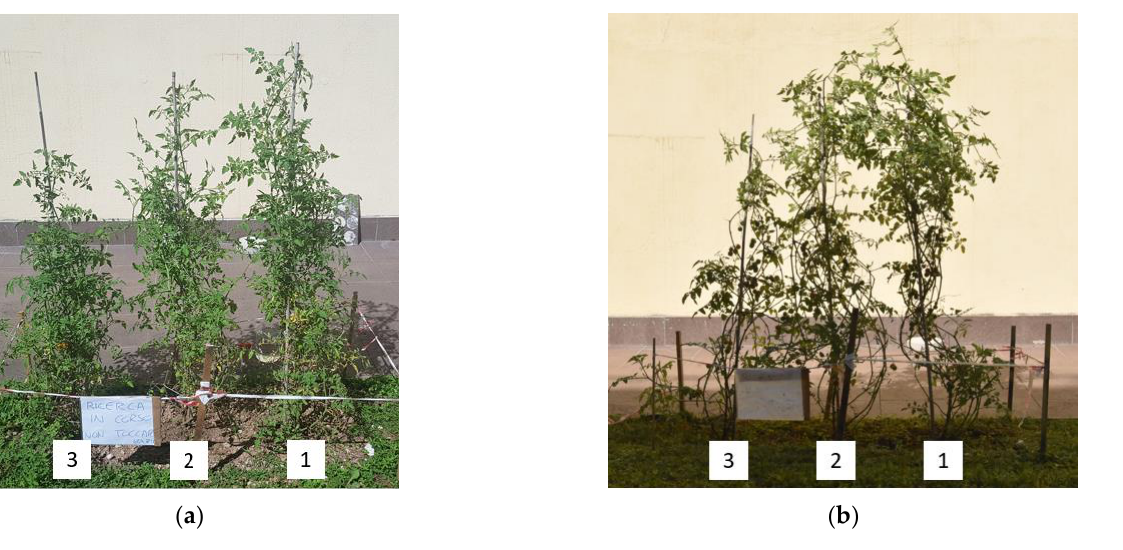
Figure 12. Representative pictures of the plant cultivation with TSC: ( a ) after 60 days and ( b ) after 80 days. (1) not crosslinked TSC, (2) crosslinked TSC, and (3) without TSC.